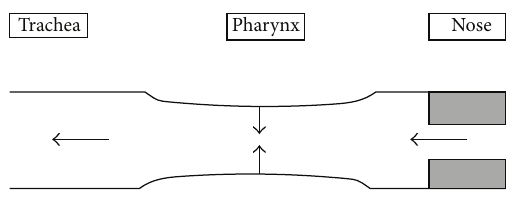
Figure 1: Starling resistor